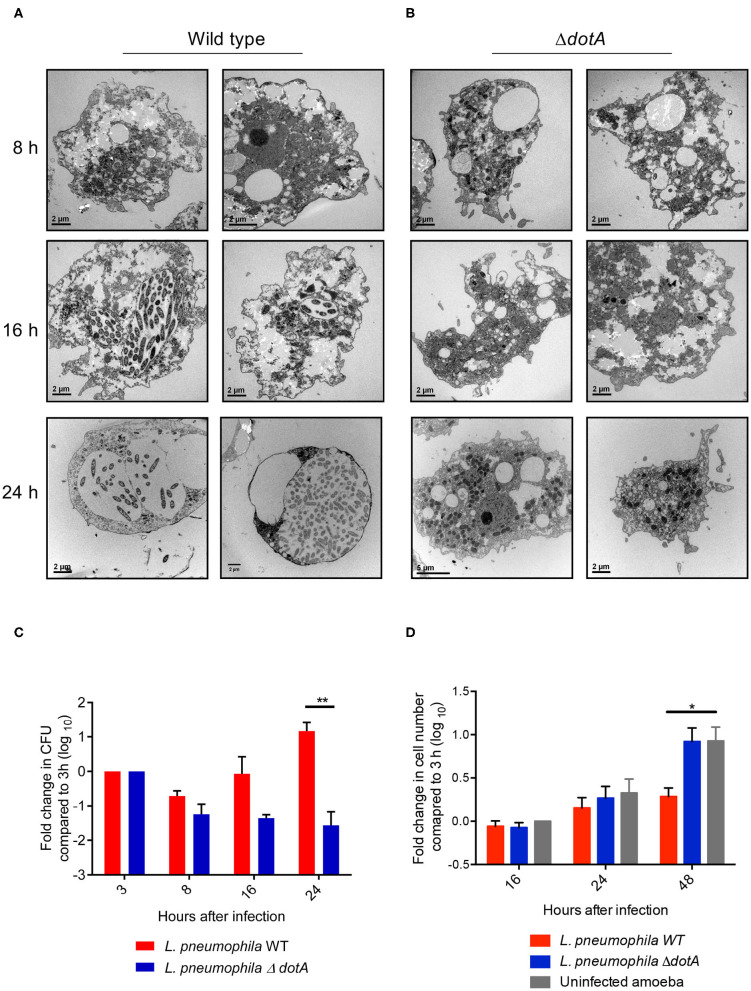
Changes in A. castellanii morphology and proliferation during L. pneumophila infection. (A) Electron micrographs of A. castellanii infected with wild type (130b) or (B) ΔdotA L. pneumophila (MOI 10) taken at 8, 16, and 24 h post infection. Two representative images of each condition are depicted. (C)
A. castellanii was infected with wild type or the ΔdotA mutant strain of L. pneumophila 130b (MOI 10) and incubated at 37°C. Amoeba were lysed and the L. pneumophila plated 3, 8, 16, and 24 h post infection. The L. pneumophila colony forming units (CFUs) are presented as a fold change in CFUs relative to 3 h post infection. Error bars represent the standard error of the mean, where n = 5 and **p < 0.01. (D)
A. castellanii was infected with wild type or the ΔdotA mutant strain of L. pneumophila 130b (MOI 10), or uninfected, and incubated at 37°C. The number of A. castellanii cells per well were quantified 0, 16, 24, and 48 h post infection. Data presented as a fold changed in cell numbers relative to 0 h. Error bars represent the standard error of the mean, where n = 3 and *p < 0.05, **p < 0.01.